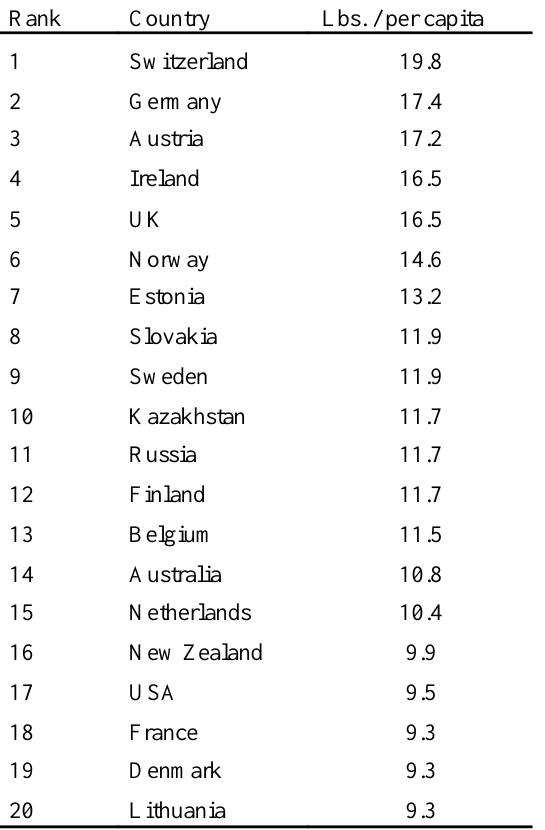
Table 2 . Top 20 Chocolate Consuming Countries in